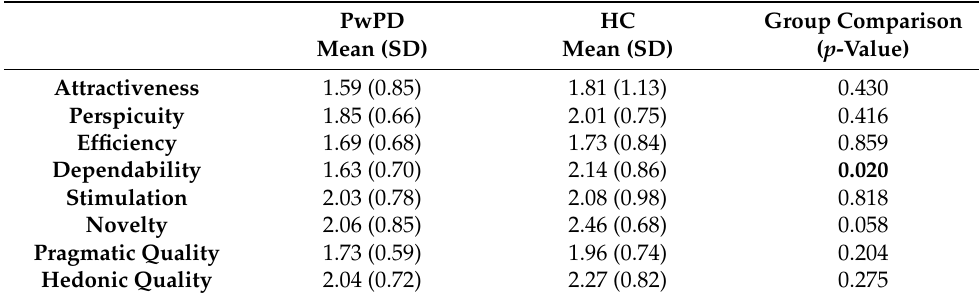
Table 7. Comparison of scores in UEQ scales and